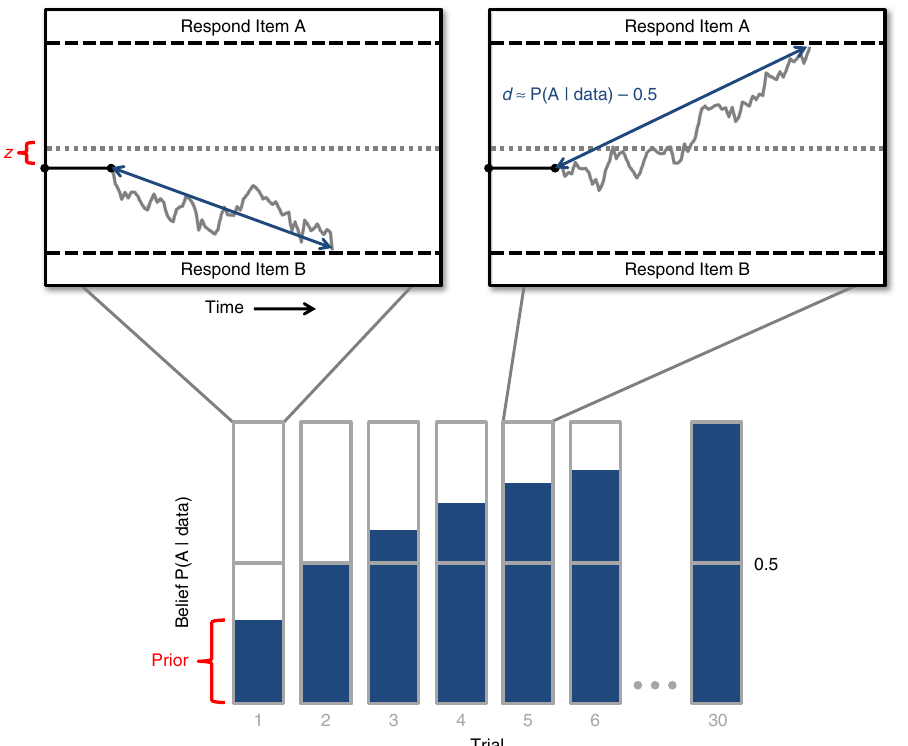
Fig. 4 Schematic representation of two-level model of information processing. The belief about the probability of an option being correct increases as the participant sees more feedback over the course of several trials ( bottom ). On each individual trial, this probability is converted into a choice by setting the drift rate in the diffusion model ( top ). In this model, there are two potential points at which the participant ’ s preference could in fl uence her behavior: the prior in the learning process, which affects the drift rate, and the bias in the starting point of the choice process, both highlighted in red . We model these in fl uences as softmax functions of the difference in the participant ’ s bids for the correct and incorrect items ( Δ v ), with inverse temperatures β Δ v (prior) and κ (choice